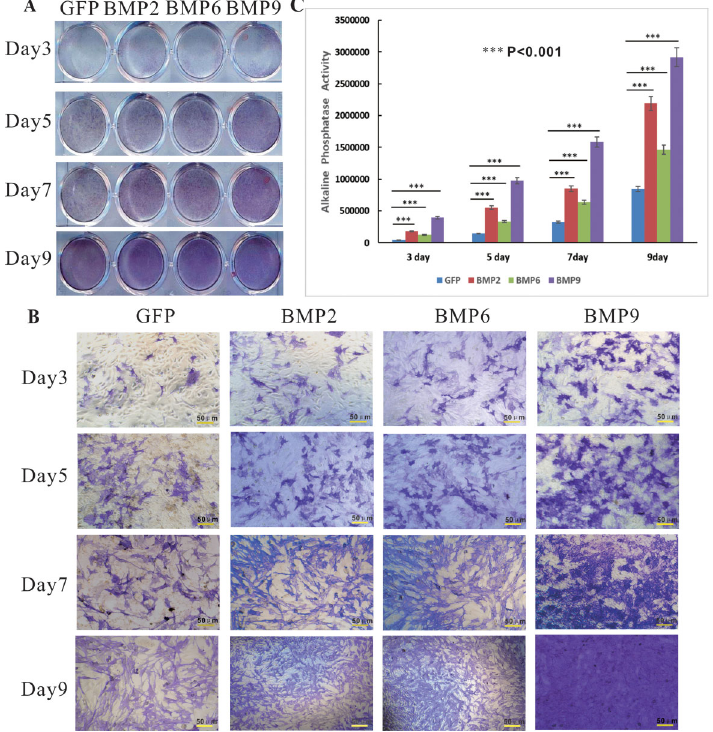
Figure 3. Bone morphogenetic proteins (BMPs) promote early mineralized marker alkaline phosphatase (ALP) activity. Subcon fl uent cells were seeded in 24-well cell culture plates and infected with Ad-BMP2, 6, 9, or Ad-GFP. At the indicated time points post-infection, cells were fi xed and histochemically stained for ALP activity ( A and B; scale bars 50 m m) or subjected to ALP quantitative analysis at the indicated time-points ( C ). Data are reported as means ± SD. Each assay was performed in triplicate. ***P o 0.001 (ANOVA). GFP: green fl uorescent